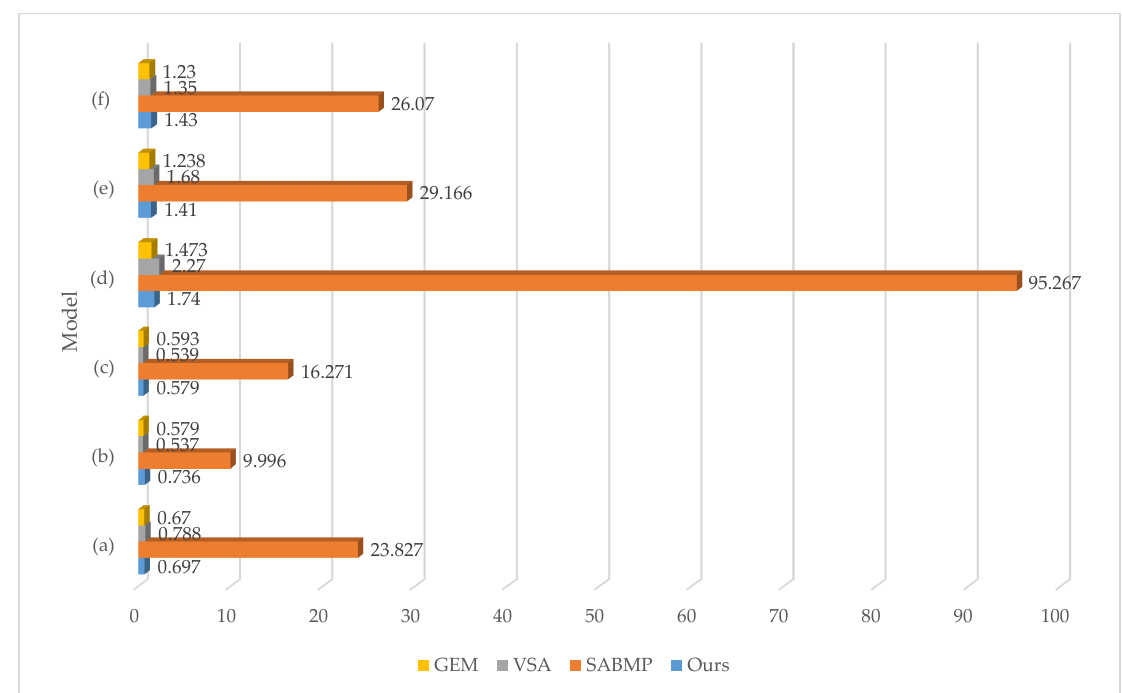
Figure 15. Comparison of running time of different methods.